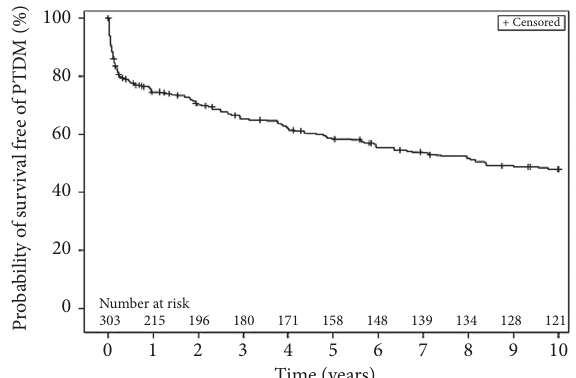
Figure 2: Kaplan Meyer curve for survival free of diabetes up to 10 years following cardiac